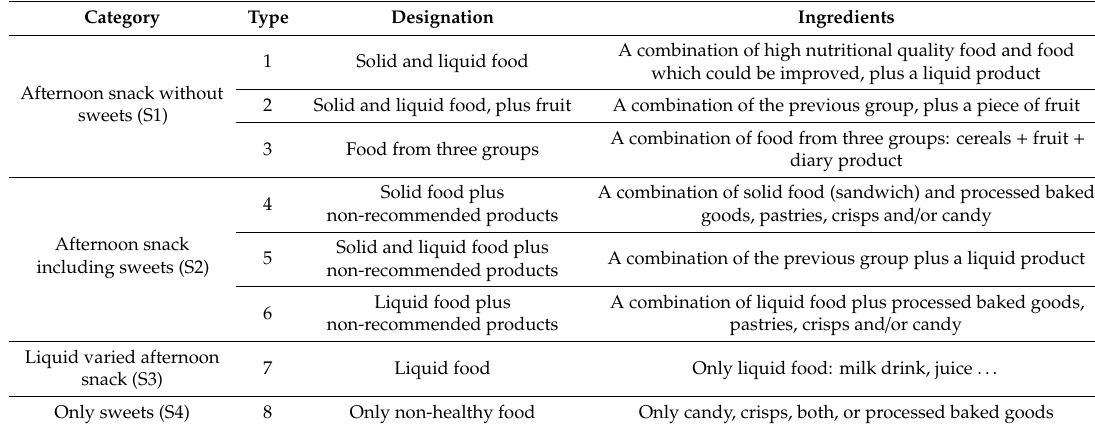
Table 2. Type of afternoon